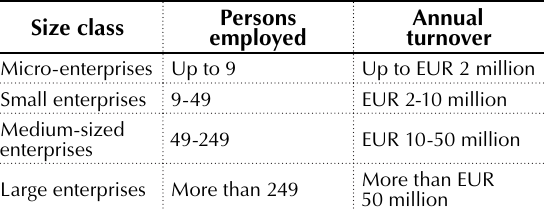
Table 1. Types of enterprises by